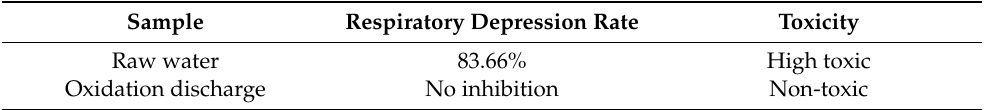
Figure 17. Changes in oxygen consumption rates in water samples measured and blank control samples. Table 3. Results of toxicity in water samples.